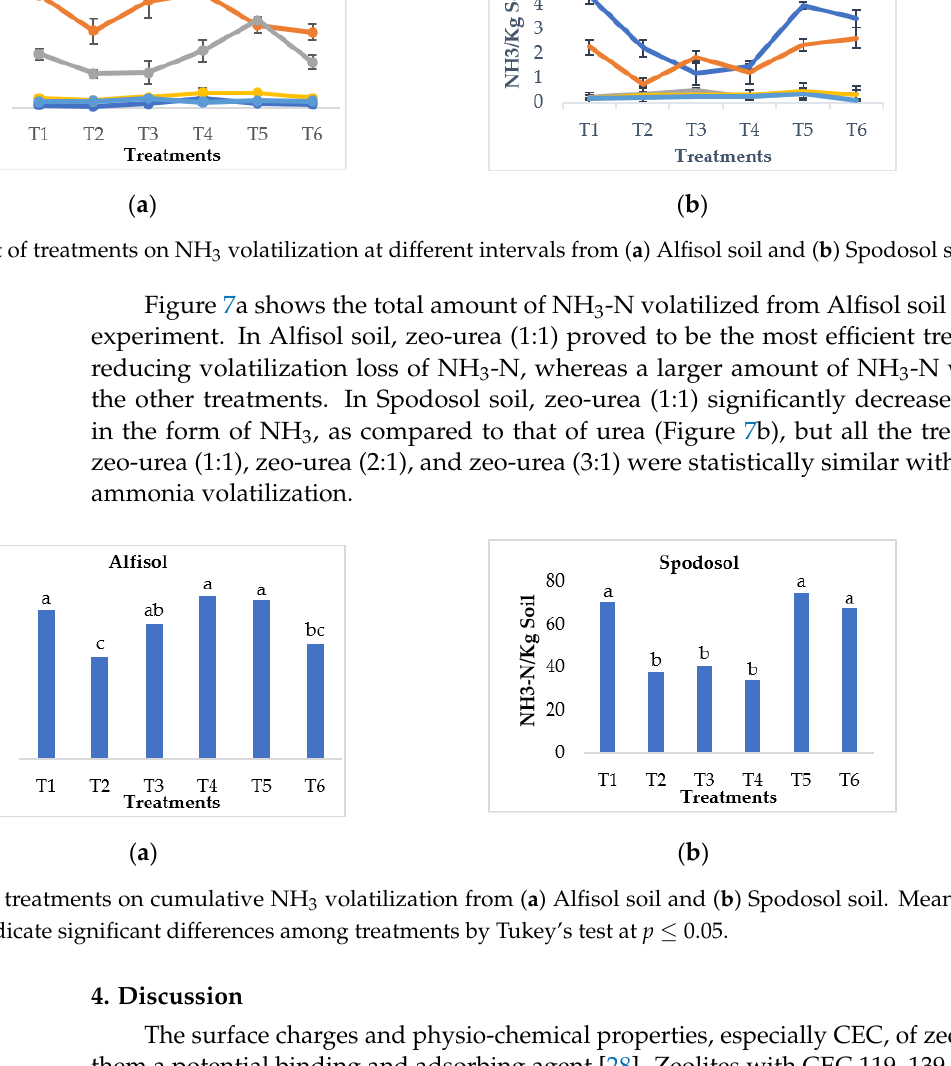
Figure 6. Effect of treatments on NH 3 volatilization at different intervals from ( a ) Alfisol soil and ( b ) Spodosol soil.